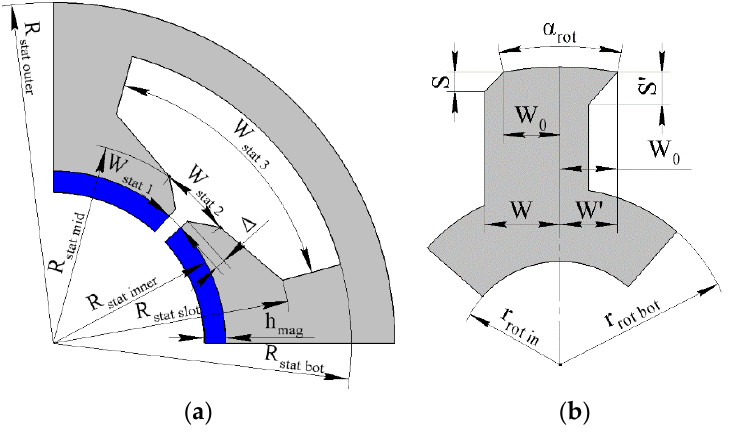
Figure 1. Design parameters of the FRM: ( a ) stator; ( b ) rotor.